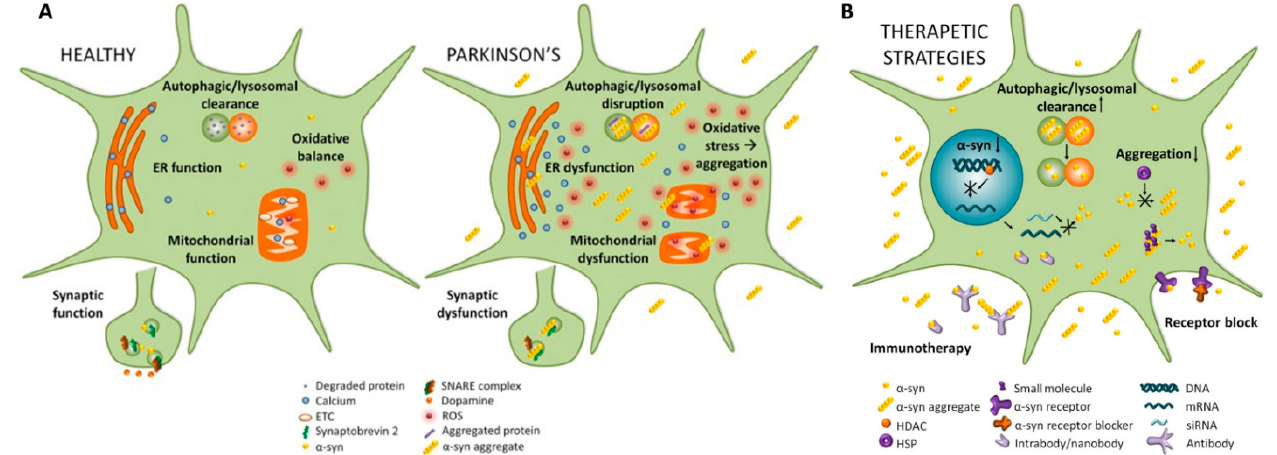
Figure 1. Implicated pathways for α -syn toxicity. ( A ). Cellular pathways in healthy subjects and PD patients are shown. In PD, there is a disfunction of clearance mechanisms based on autophagia and lysosomal activity leading to an accumulation of aggregated protein, which impair these homeostatic mechanisms promoting protein aggregation. In PD, endoplasmic reticulum and mitochondrial functions are impaired. In turn, pathological α -syn aggregates interact with several cellular proteins and functions, causing synaptic dysfunction and neurodegeneration. ( B ). Cellular pathways potential targets of disease-modifying therapeutic strategies. [35].